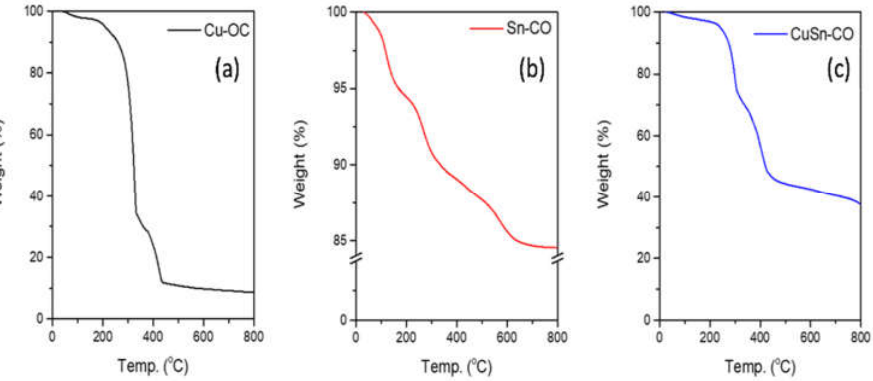
Figure 5. Thermogravimetric analyses for as-synthesized ( a ) Cu-OC, ( b ) Sn-OC, and ( c ) CuSn-OC.